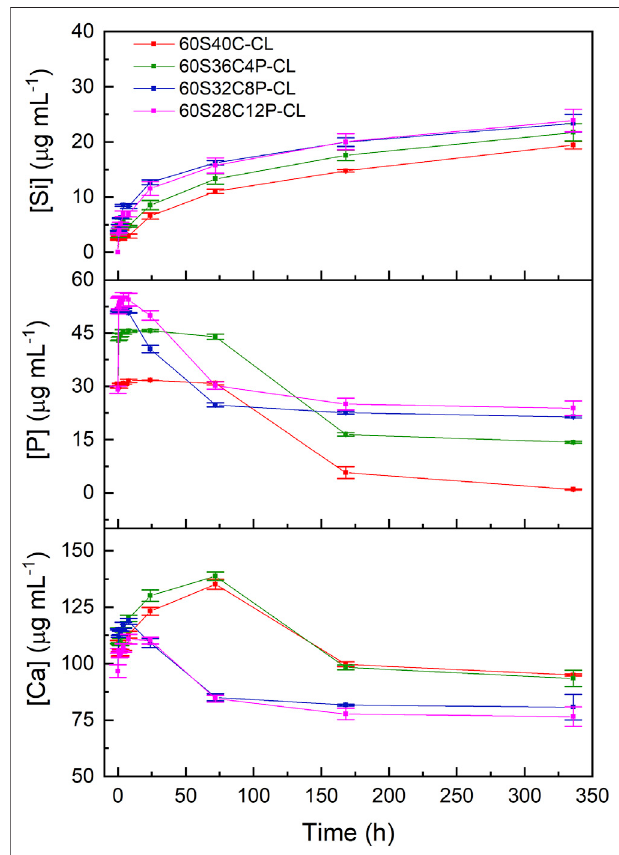
FIGURE 5 | ICP-OES of SBF after immersion of SiO 2 -CaO-P 2 O 5 /PTHF/ PCL-diCOOH hybrid powders. Error bars are standard deviations from the mean values for n =